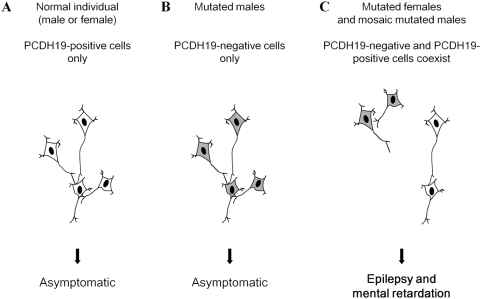
Schematic illustration of the cellular interference mechanism associated with PCDH19 mutations.A) In normal individuals, characterized by a homogeneous population of PCDH19-positive cells, neurons are able to form normal neuronal networks; B) In mutated male patients, hemizygosity leads to a homogeneous population of PCDH19-negative cells; in this condition, neurons preserve the ability to form normal neuronal networks; C) In heterozygous mutated females, random X inactivation leads to the co-existence of two PCDH19-positive and PCDH19-negative cell populations. These two cell populations cause divergent cell sorting and migration (due to attractive or repulsive interactions) and lead to abnormal neuronal networks. Somatic mosaicism in mutated males gives rise to the same pathological situation. The precise mechanisms by which the neuronal networks are altered are still unknown.